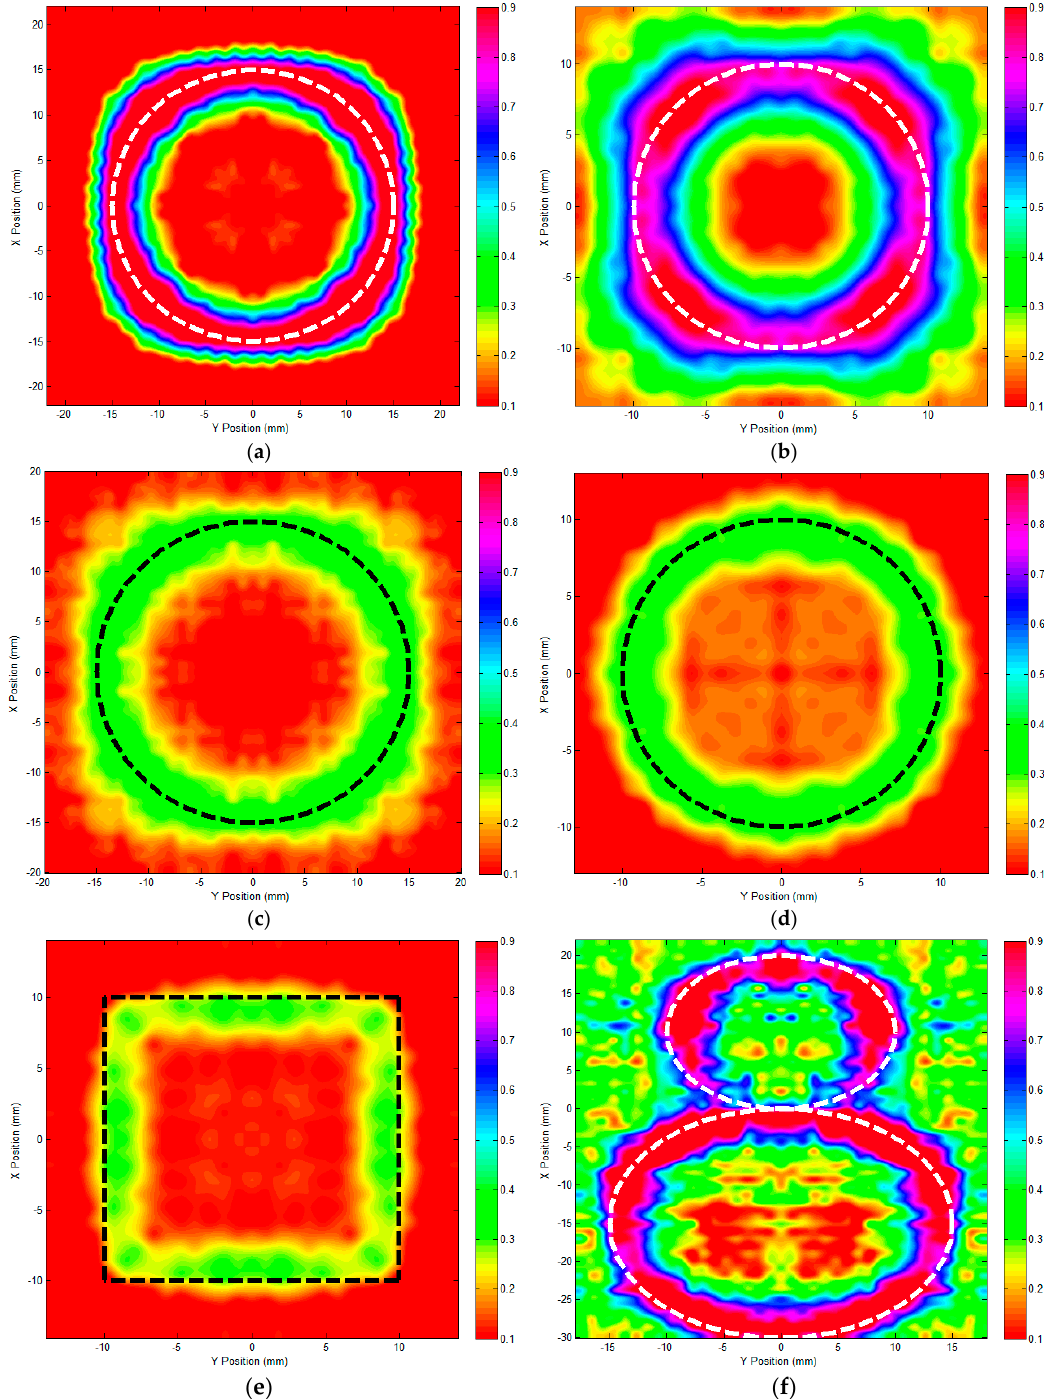
Figure 10. Images of subsurface corrosion via GPEC with uniform field excitation. ( a ) Corrosion #1; ( b ) Corrosion #2; ( c ) Corrosion #3; ( d ) Corrosion #4; ( e ) Corrosion #5; ( f ) Corrosion #6.